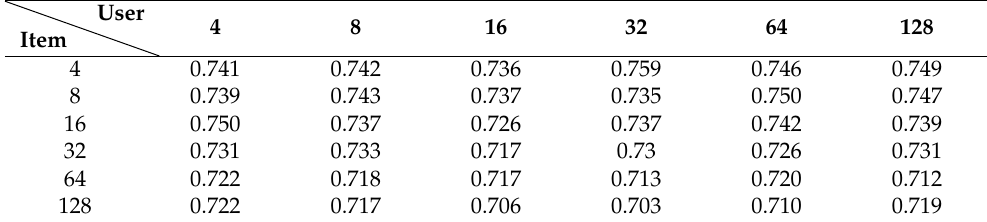
Table 6. The effect of size of triple set on AUC in Book-Crossing.